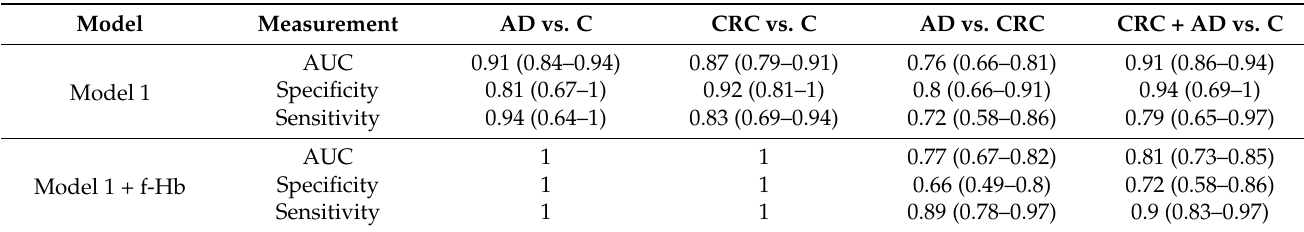
Table 4. Results of the area under curve (AUC) of the receiver operating characteristic (ROC) curve in the different models tested. AD vs. C, adenoma vs. healthy controls; CRC vs. C, colorectal cancer vs. healthy controls; CRC vs. AD, colorectal cancer vs. adenoma; CRC + AD vs. C, adenomas and colorectal cancer vs. controls. Model 1, sex, age, metabolome and microbiome data as predictive values; Model 2, sex, age and genetic data (polygenic score and PC1–PC4 components) as predictive values; f-Hb, fecal hemoglobin test as predictive